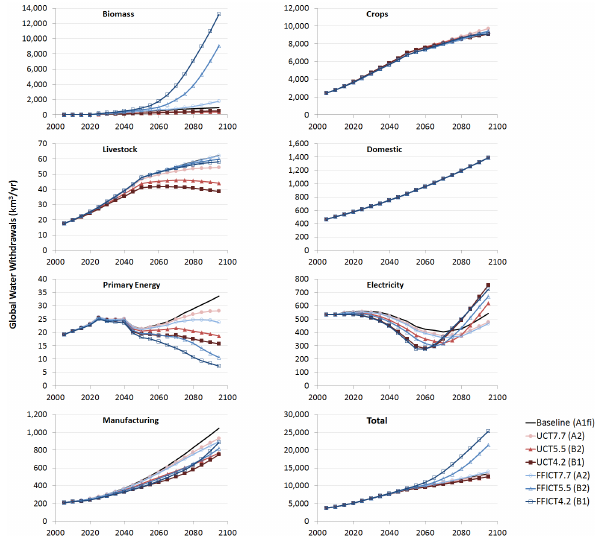
Figure 8: GCAM’s estimates of global water demands (withdrawals) for the baseline (A1fi) scenario (no climate policy) and the six climate change mitigation policy scenarios (UCT7.7 (A2), UCT5.5 (B2), UCT4.2 (B1), FFICT7.7 (A2), FFICT5.5 (B2), FFICT4.2 (B1)) for each of the water demand sectors